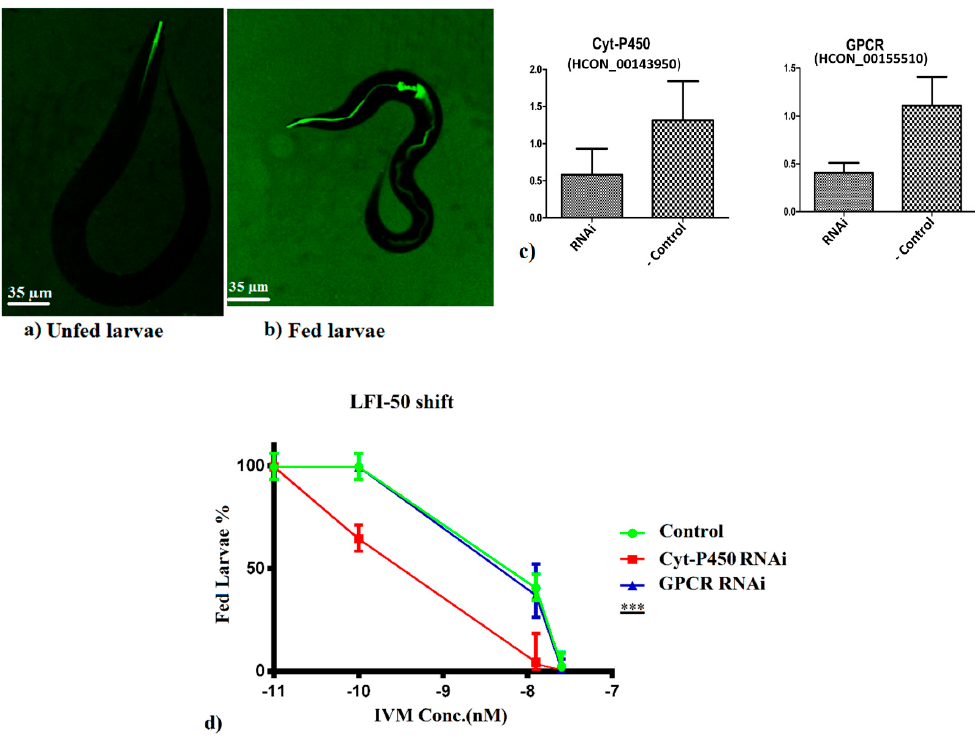
Figure 6. RNAi assays for functional validations. ( a , b ) Larval feeding of FITC-labelled E. coli . ( c ) Results of qPCR. Transcription level was dropped in both the genes when blocked by RNAi in comparison to RNAi negative control. ( d ) Impact of RNAi-based silencing of candidate genes on IVM e ffi cacy against H. contortus L2 larvae. In the control assay, no IVM was used. Silencing of GPCR gene (HCON_00155510) showed similar response as that of control. Silencing of Cyt-P450 gene (HCON_00143950) showed a clear drop in LFI-50 against the increasing concentration of IVM. Experiments were replicated in triplicates. Values represent mean ± SD. *** p <